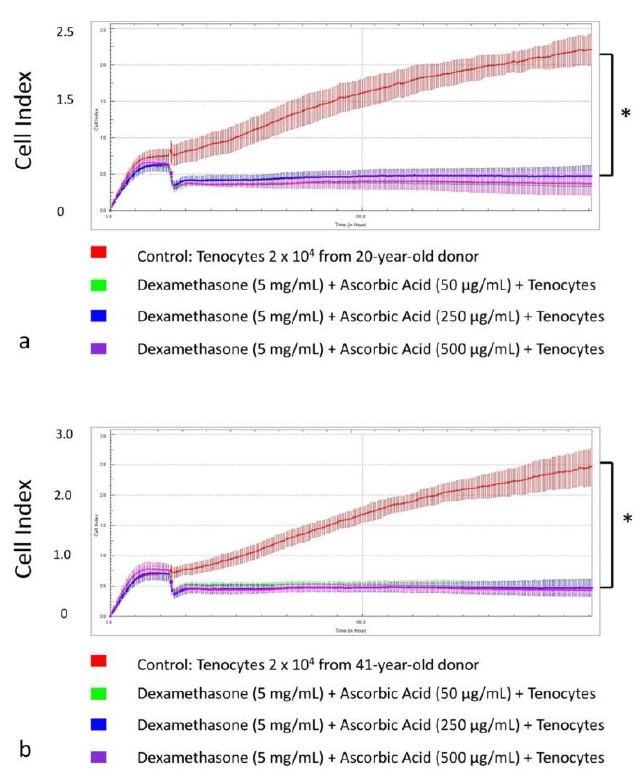
Figure 7. Real-time changes of cell index when tenocytes were exposed to 5 mg/mL of dexamethasone and different concentrations of ascorbic acid. ( a ) Cell index when tenocytes were exposed to 50, 250, and 500 μg/mL ascorbic acid in the 20-year-old patient. ( b ) Cell index when tenocytes were exposed to 50, 250, and 500 μg/mL ascorbic acid in the 41-year-old patient. * p < 0.05.